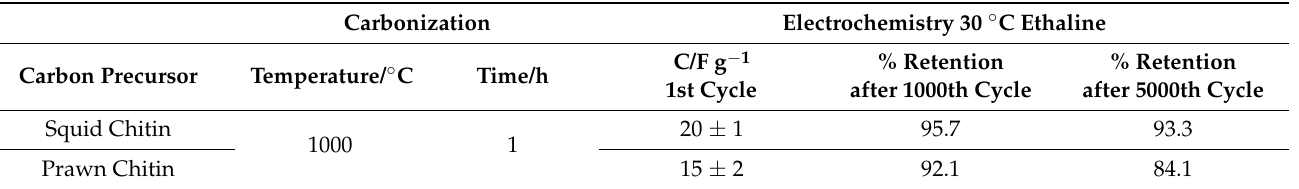
Table 5. Specific capacitance and % retention after 1000 and 5000 cycles of squid and prawn chitins- based carbons samples (1 A g − 1